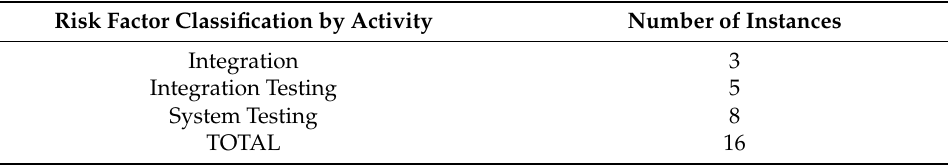
Table 4. The risk factors in integration and system testing